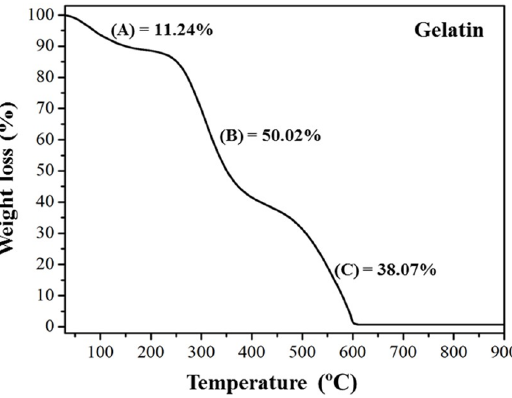
Figure 1. Thermogravimetric curve of natural gelatin.